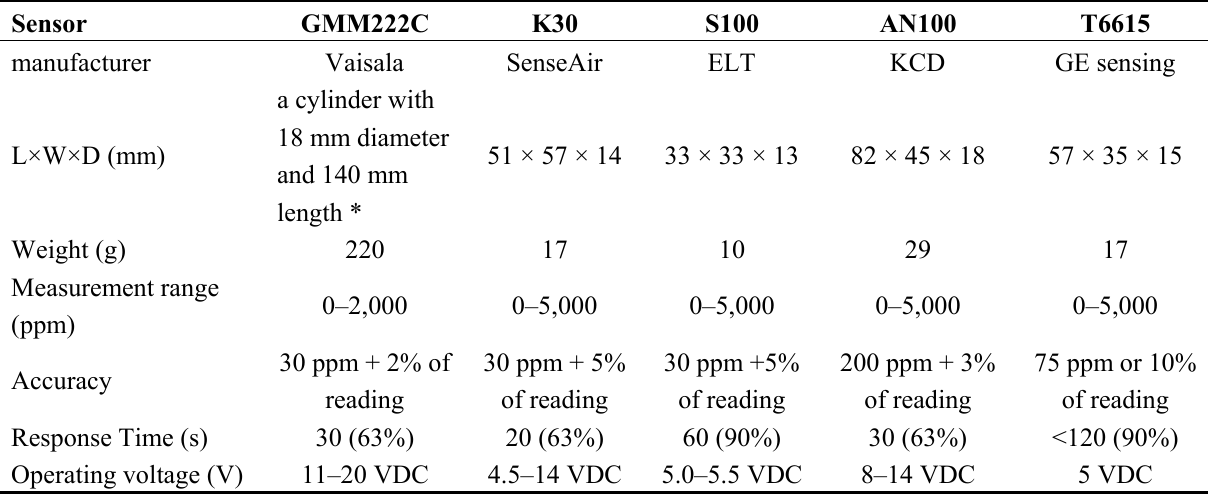
Table 1. Catalog specifications of five commercial diffusion type NDIR CO